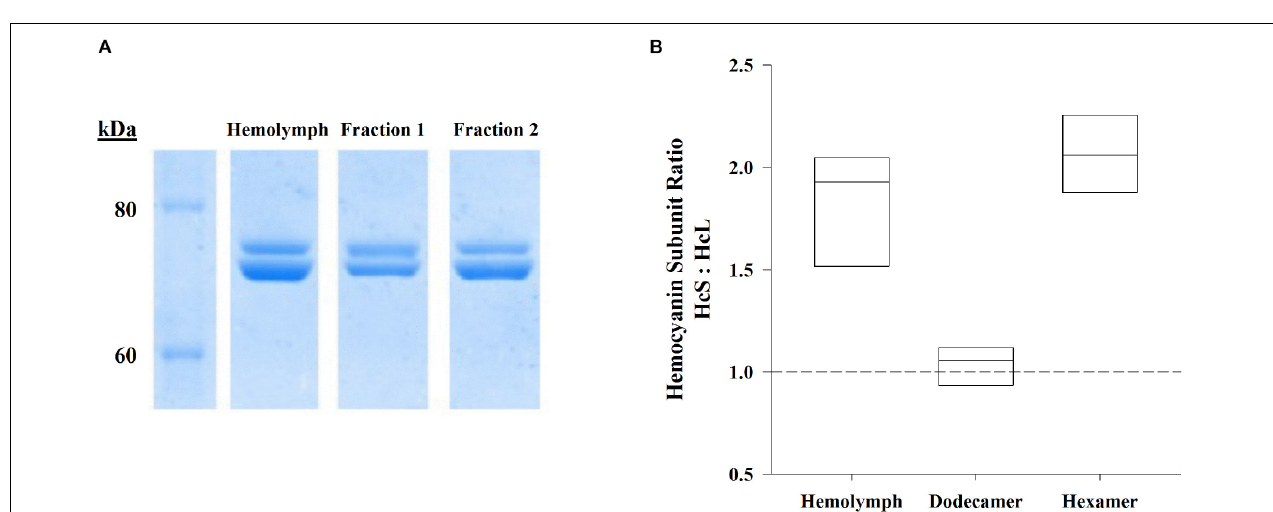
FIGURE 2 | Hemolymph samples and their shrimp-matched dodecamer and hexamer fractions ( n = 8) separated by SE-HPLC (BioSep SEC s4000, Phenomenex) were further separated by denaturing PAGE. (A) Representative SDS-PAGE (Bis-Tris 4–12%) gel visualized by Coomassie R-250 staining shows hemocyanin subunits HcL (top) and HcS (bottom) for hemolymph, dodecamer fractions, and hexamer fractions against Novex Unstained Protein Standard (Life Technologies). (B) Ratios of HcS:HcL were significantly different for hemolymph hemocyanins as well as their corresponding fractionated hemocyanin oligomers (repeated measures ANOVA, F 2 , 7 = 94.8, p = 7.3 × 10 − 9 ). Boxes indicate interquartile ranges and median HcS:HcL ratios (solid lines). The dashed reference line indicates a 1:1